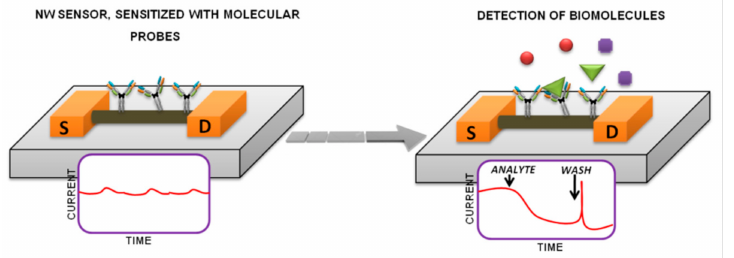
Figure 1. The Si-NW-sensors scheme and representation of the nanowire-based detection of biomolecules. Abbreviations: S–source;